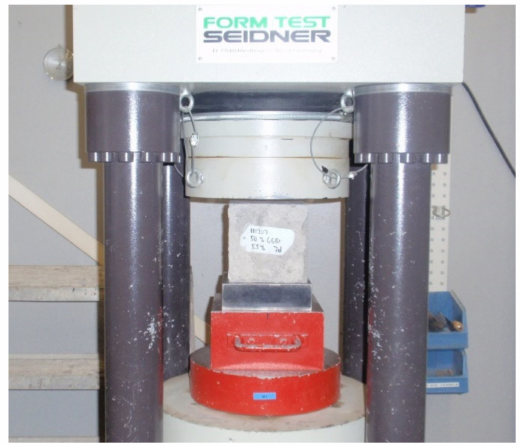
Figure 9. Compressive strength test